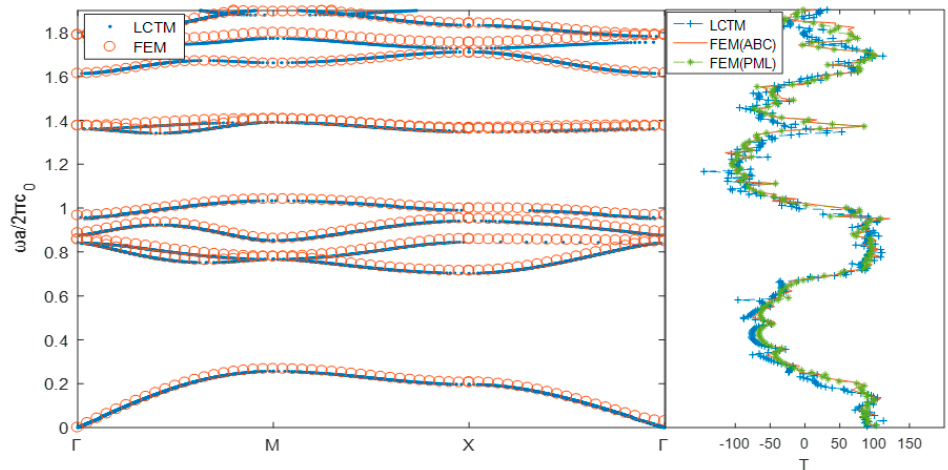
Γ− Γ− direc- direc-